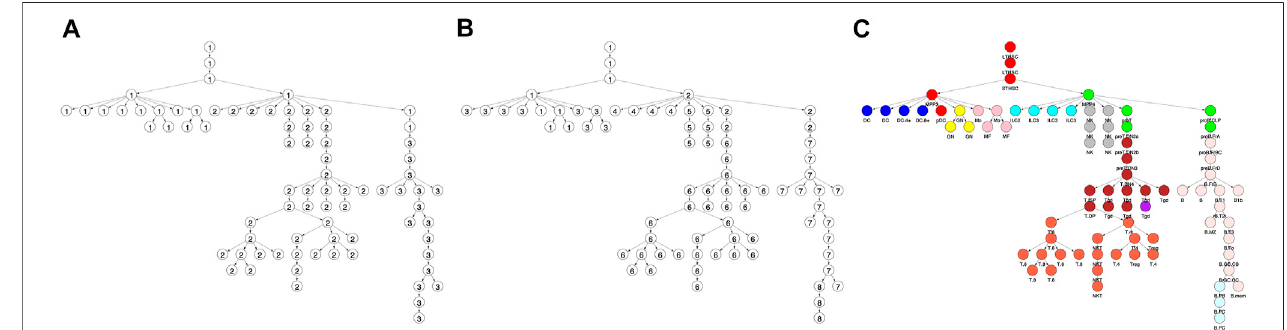
FIGURE 1 | Locus accessibility across locus clusters reveals cell type speci fi c patterns. Shown is the fraction of loci that were accessible within a locus (i.e. row) cluster across each of the cell types in the differentiation tree. Trees correspond to locus cluster (A) 5, (B) 7, and (C) 9. Within each tree, the size of a vertex provides the fractionoflociintheclusterthatwereaccessibleforthecorrespondingcelltype.Forexample,cluster5had5,947lociwith87and2%accessibleintheDC.4+(redvertex) and ILC2 cell types, respectively, as shown in panel A ( Figure 4 provides the same data, but in a heatmap